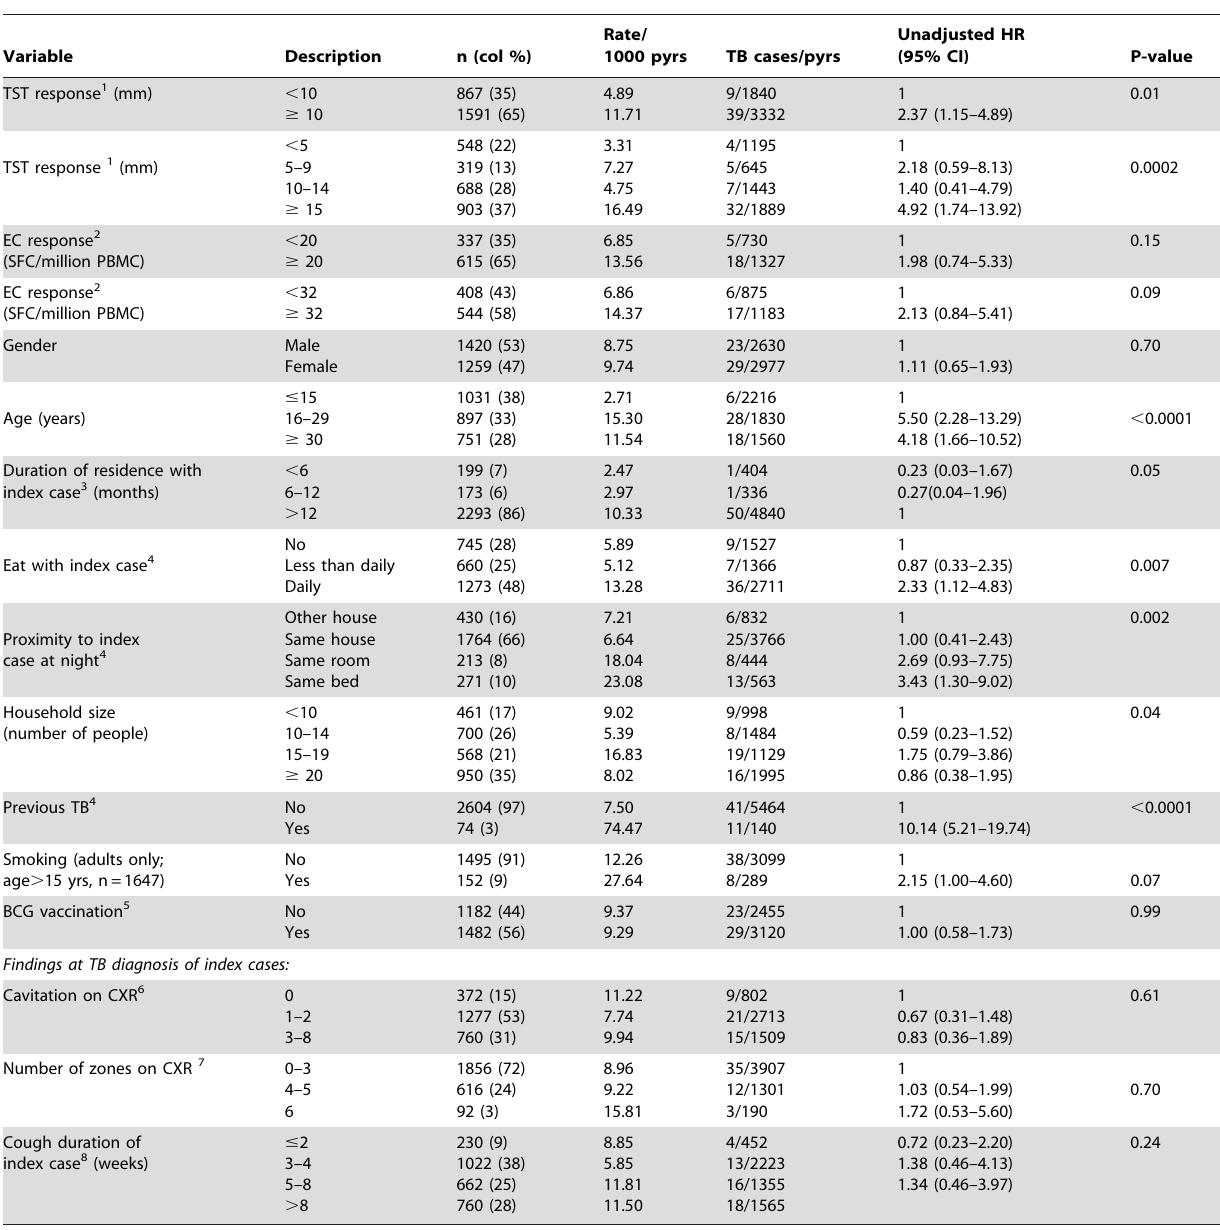
Table 3. Univariable analysis of time to TB episode; hazard ratios, 95% CI and P-values (n max =2679) - All TB cases